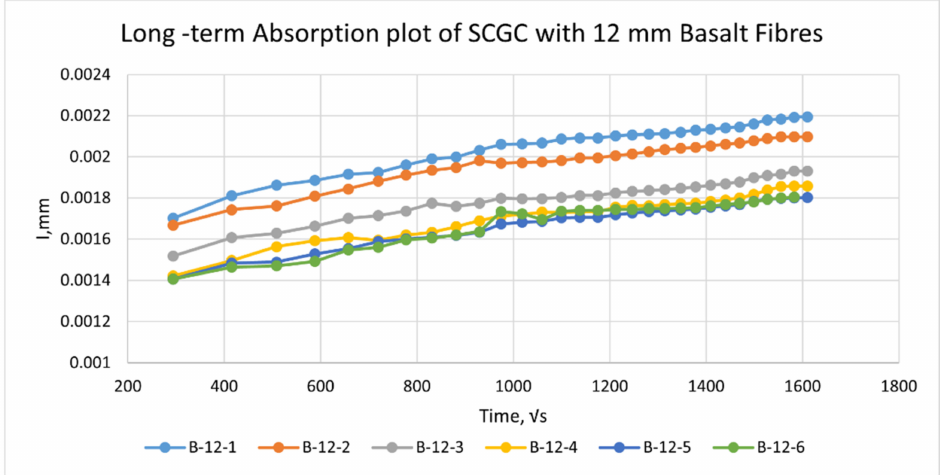
Figure 9. Long-term absorption plot of SCGC with 12 mm basalt fibres. The initial absorption rate of the fibre SCGC mix modified with 12 mm basalt fibres was 0.006 mm 2 /s 0.5 , followed by even lower rates of 0.0003 mm 2 /s 0.5 after 7 days of exposure and finally reaching 2.9 × 10 − 7 mm 2 /s 0.5 after 1 month exposure. The